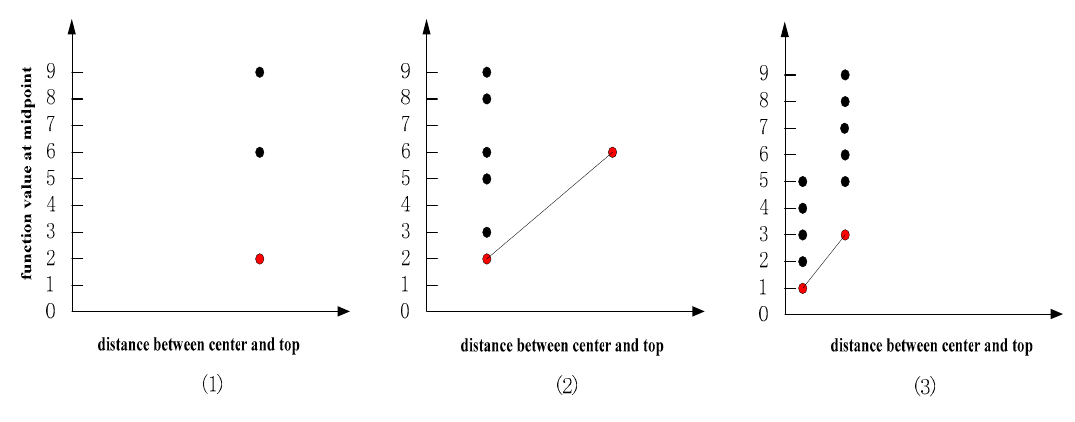
Figure 17. The potential optimal hyper-rectangle of each iteration.